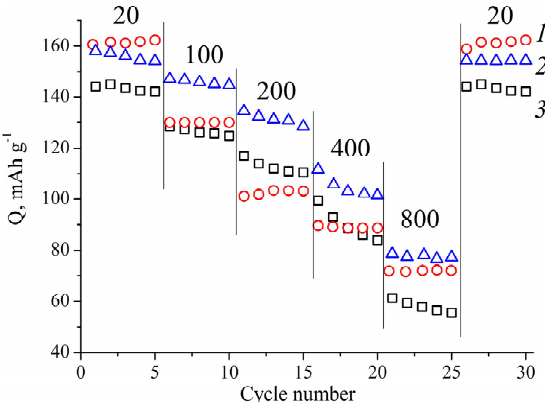
Fig. 6. Charge/discharge curves of LFP/C-600-{II} obtained using PVP (1) , sucr (2) and PEG (3) as the carbon source. Current density is 20 mA g -1 .